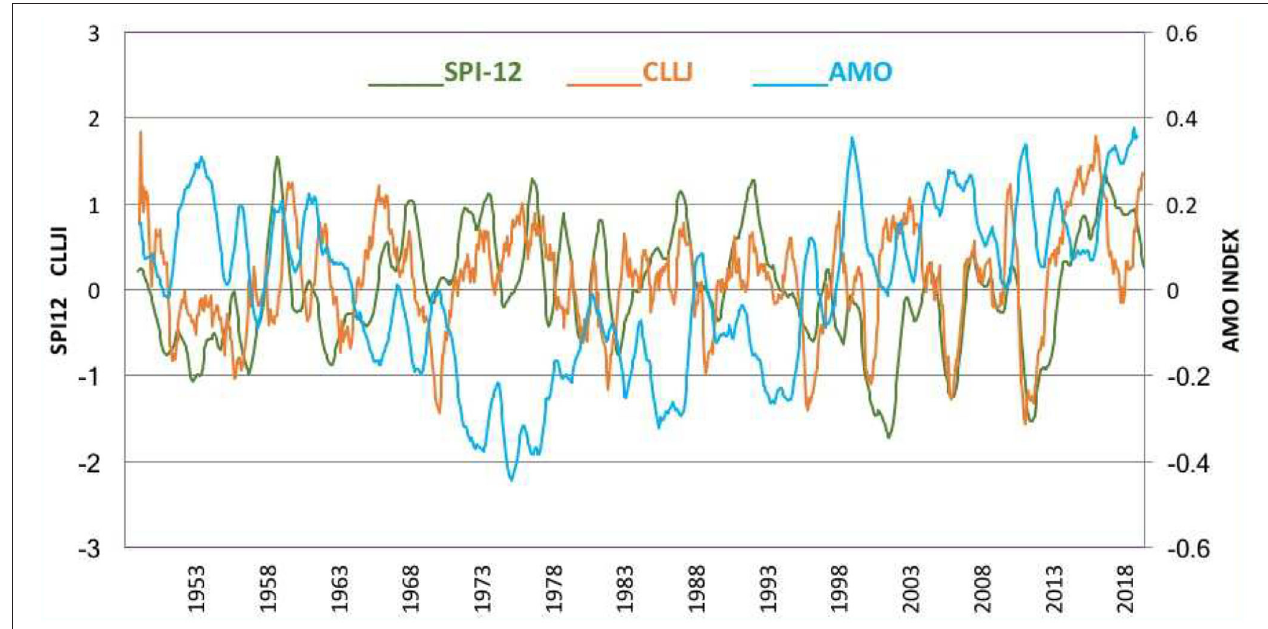
FIGURE 6 | Time series of the smoothed (moving avg. 12 points) version of the: SPI-12 index around the MMA (green line) of the CLLJ index (red line) and the AMO index (blue line).